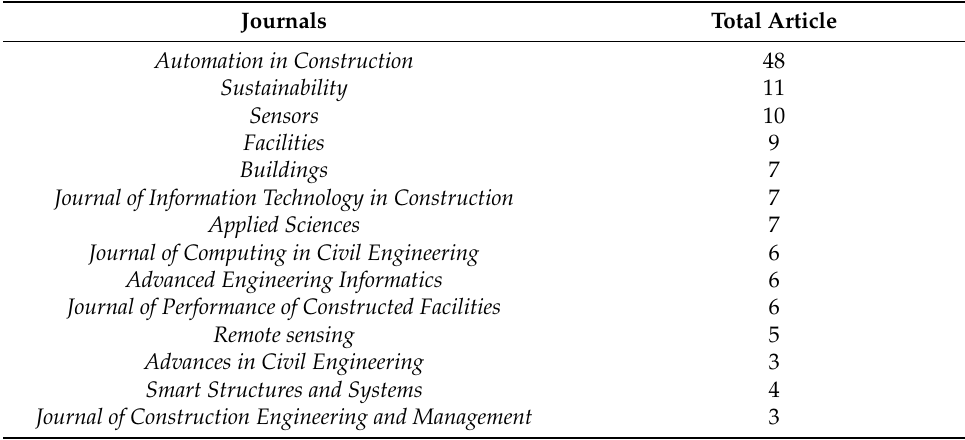
Figure 3. Frequency keywords clustering. 4. Content Analysis By means of keyword clustering, the reviewed papers were categorized into groups based on their main purpose and modelling methodology. The dominant aims of each paper determined the category in which they were placed; however, some papers had the potential to be classified in alternate categories. At the end of each section, the forthcoming agenda related to the category was mentioned in order to facilitate future research. Figure 4 contains a summary of the content analyses and research paper subjects. Based on the research focus and contribution, the reviewed papers were categorized into some parts to cover our paper subject.